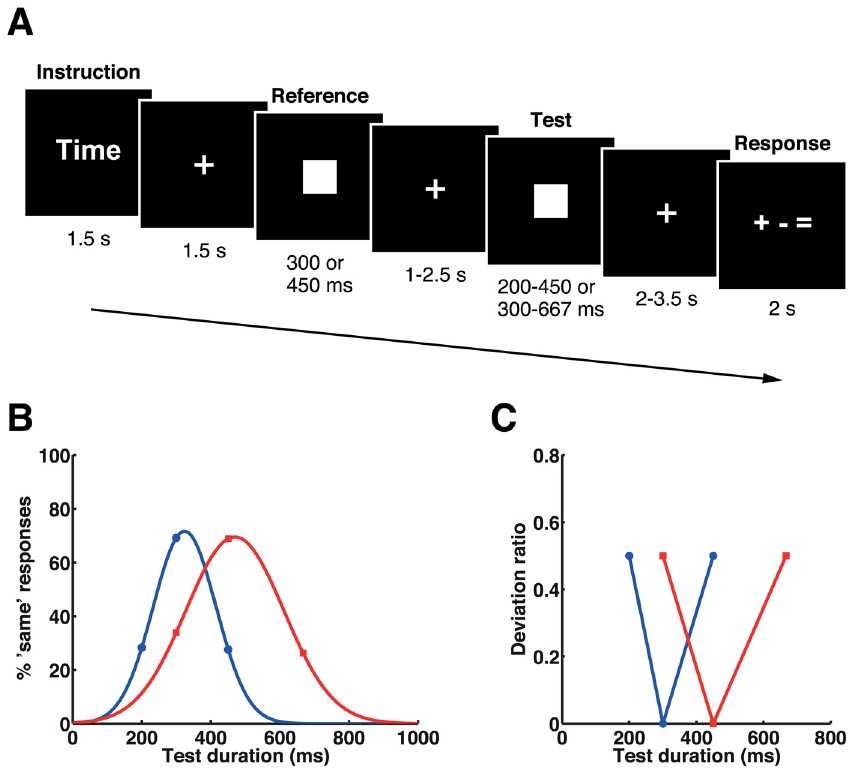
Fig 7. Stimulus sequence, mean task performances, and deviation ratios in experiment 4. (A) The stimulus sequence. Participants were asked to respond with whether the duration of the second (test) stimulus was shorter, longer, or the same compared with the first (reference) stimulus. (B) Mean task performances. Proportions of the “ same ” responses for the 300 ms (blue) and the 450 ms (red) reference blocks were fitted by Gaussian functions for presentation purpose. Please refer to S1 Data for the numerical values underlying this figure. (C) Plots of deviation ratios for each set of stimulus durations in the 300 ms reference block (blue) and in the 450 ms reference block